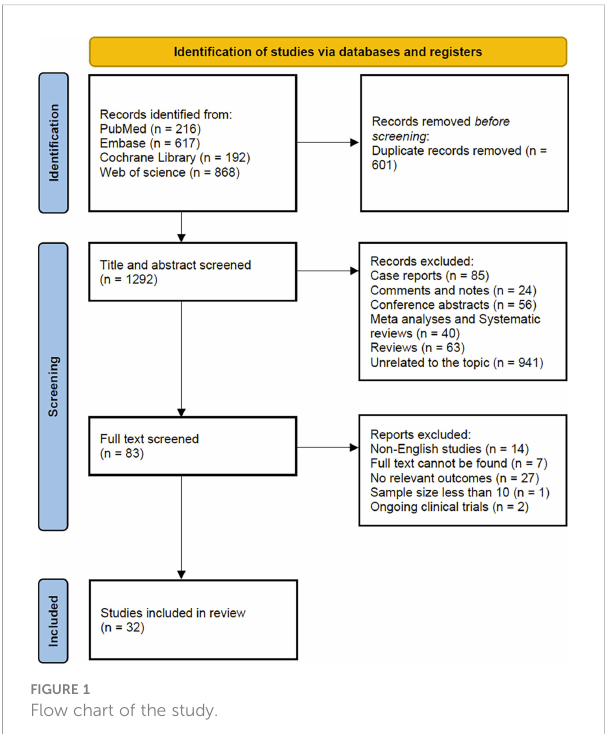
FIGURE 1 Flow chart of the